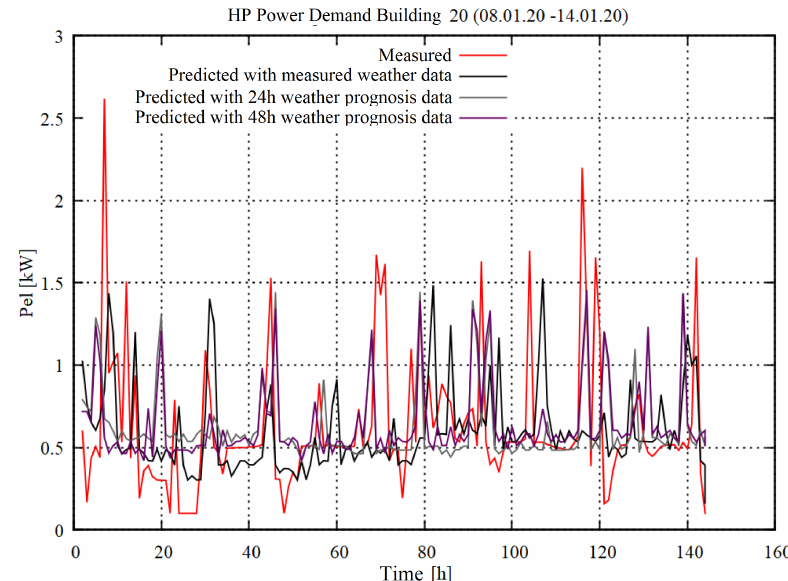
Figure A3. Impact of weather prediction inaccuracy on electrical heat pump power demand.